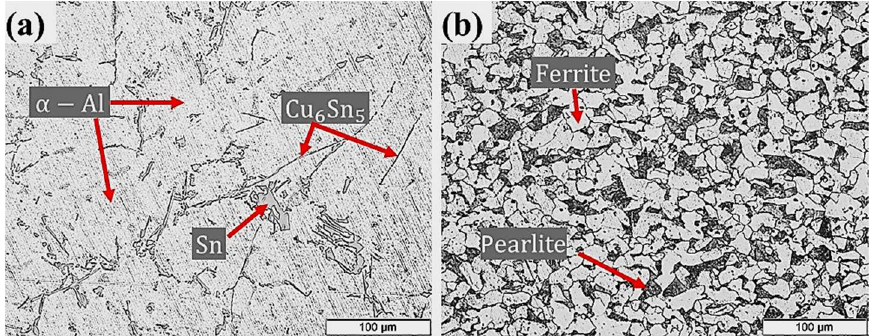
Figure 2. Microstructures of ( a ) Al-bearing alloy and ( b ) steel substrate, used for preparing bimetallic casting.